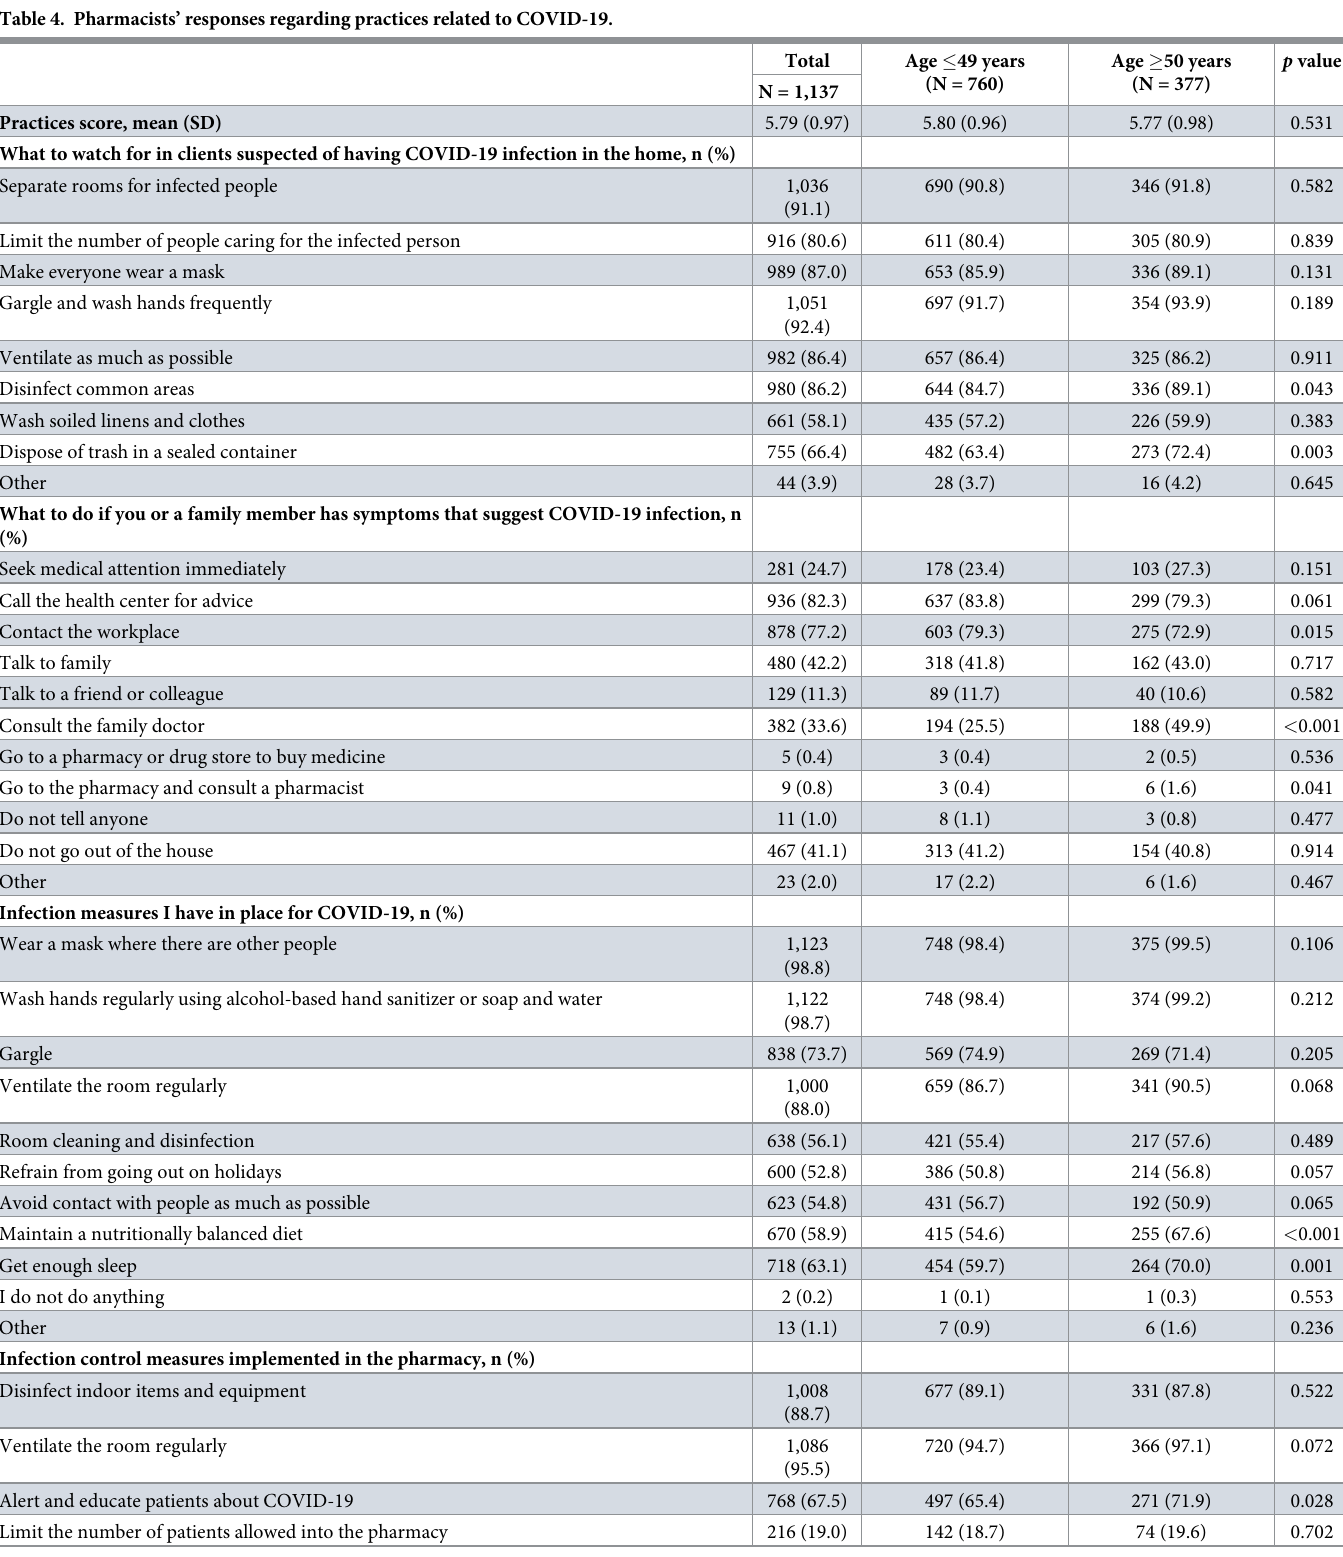
Table 4. Pharmacists’ responses regarding practices related to